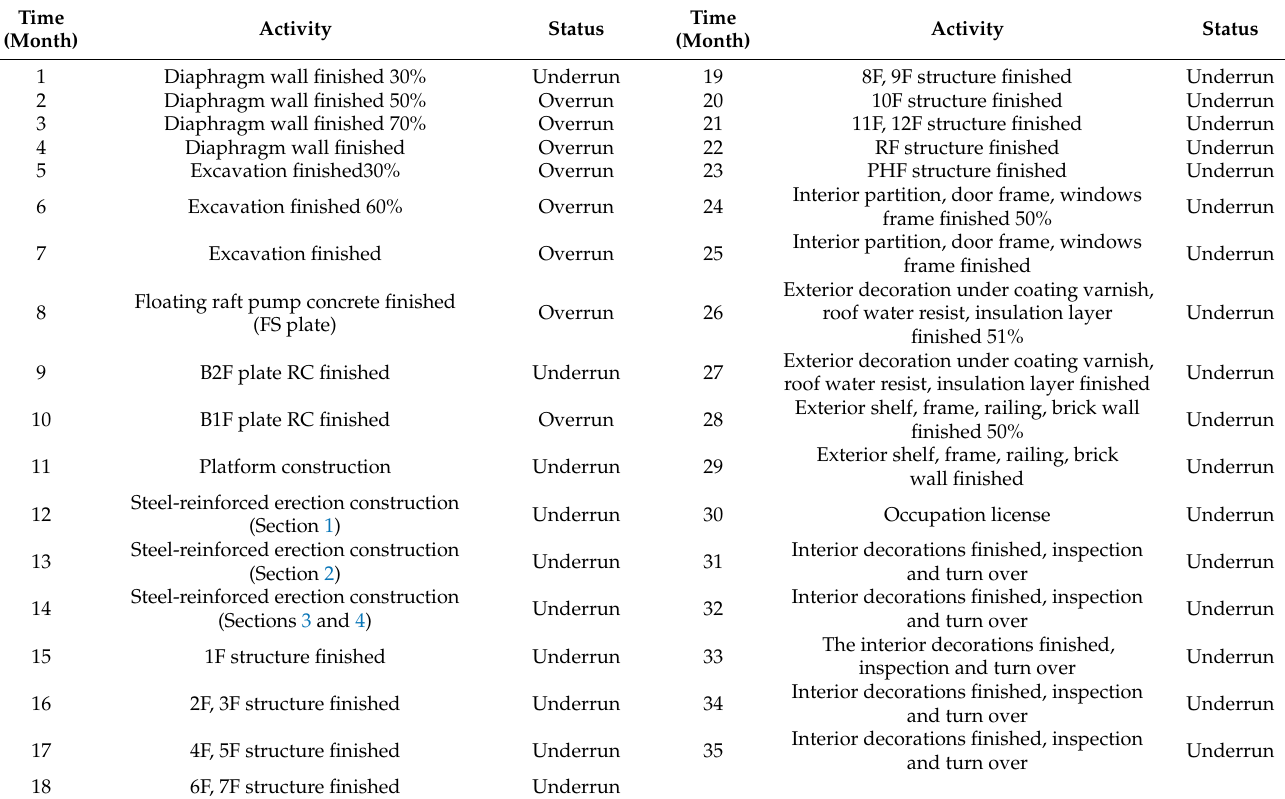
Table 3. Status of Cost Overrun report at SRC